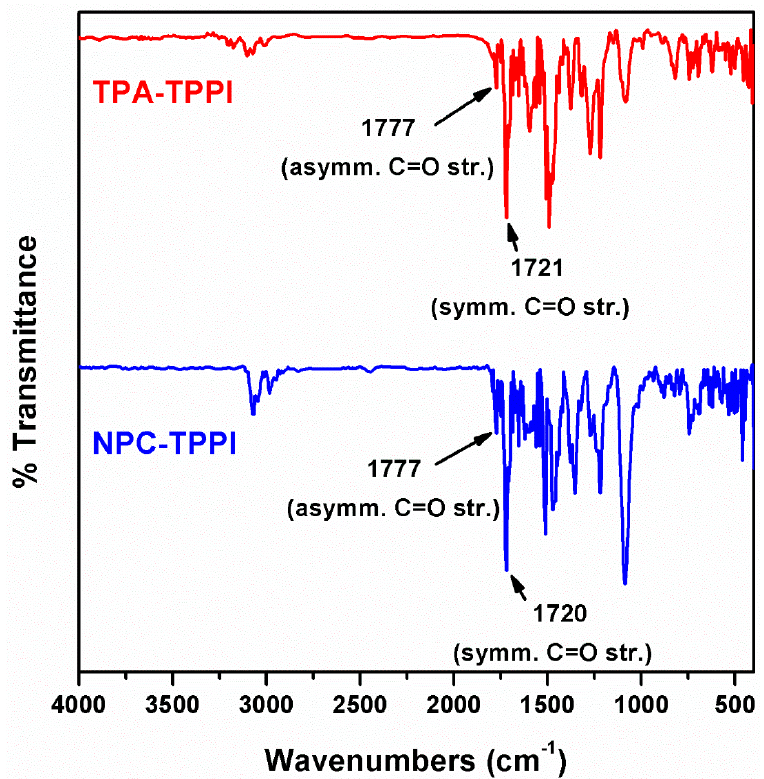
Figure 12. IR spectra of elecytrodeposited polymer films TPA–TPPI and NPC–TPPI.